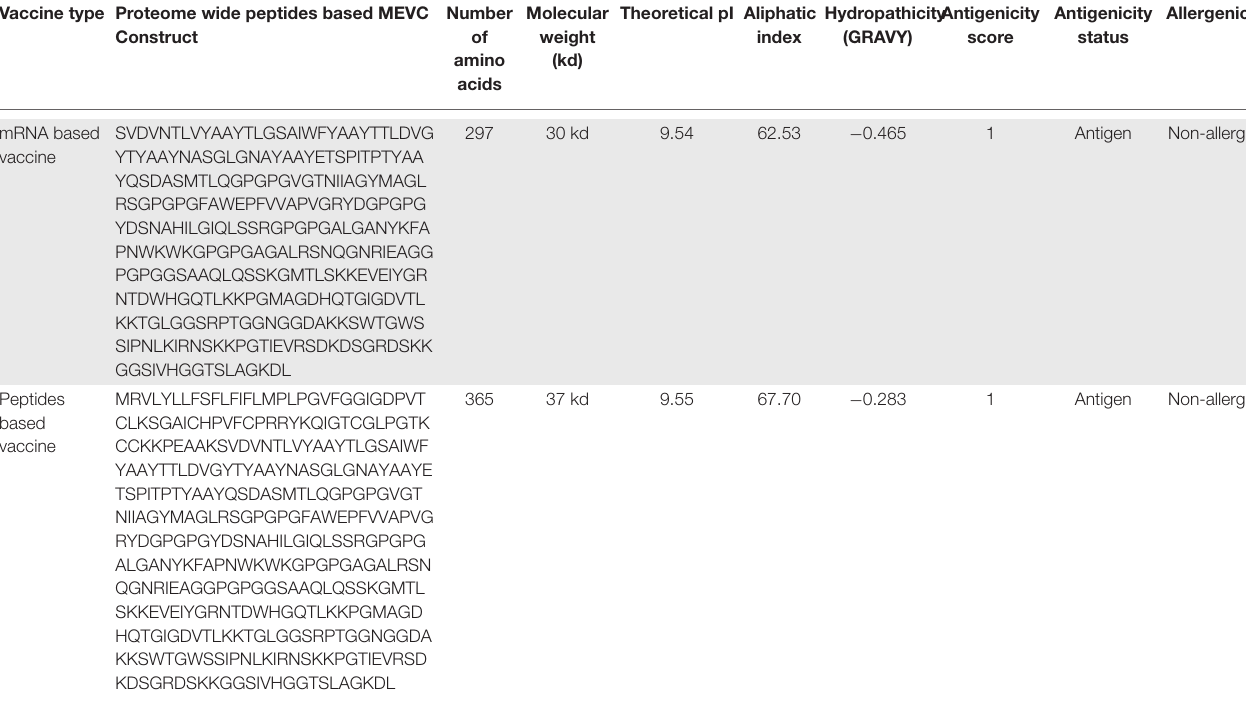
TABLE 3 | The full-length peptides-based MEVC design with explored physiochemical properties. Vaccine type Proteome wide peptides based MEVC